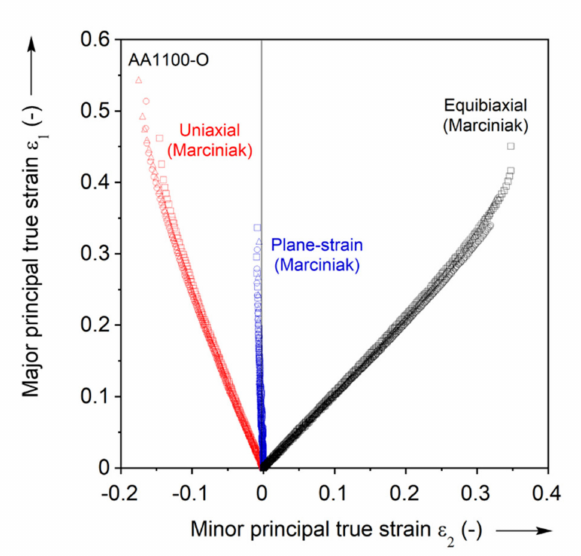
Figure 16. Strain paths recorded during the Marciniak FLC experiments. Three for each Marciniak experiment are